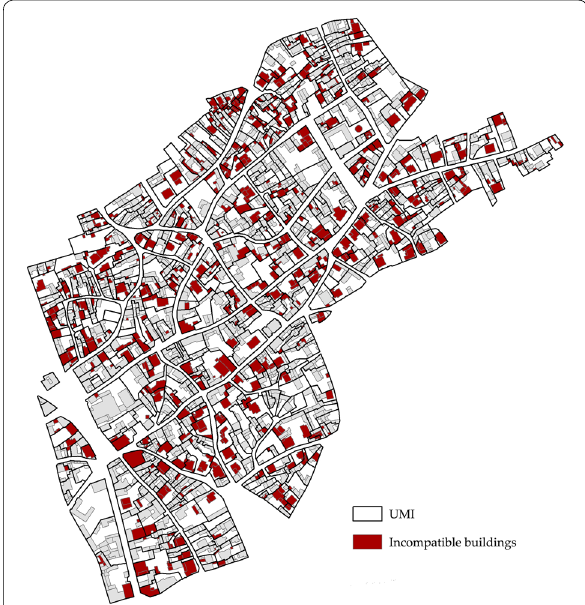
Fig. 3 Identification of recent typologically incompatible buildings in the historic centre of Villasor. Detailed Urban Plan Data processed on GIS software